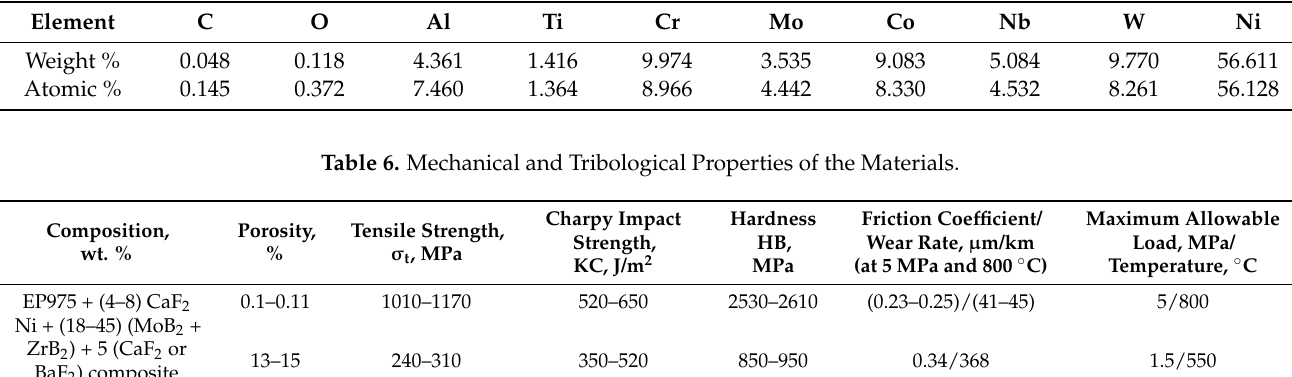
Table 5. Spectrum2: Concentration Ratio of Alloying Elements in a Composite’s Matrix.